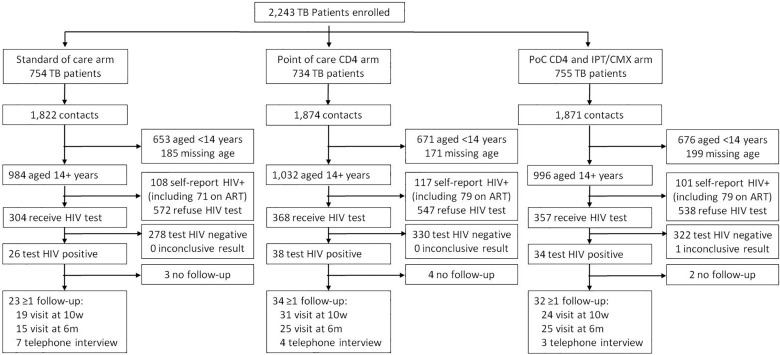
CONSORT diagram.